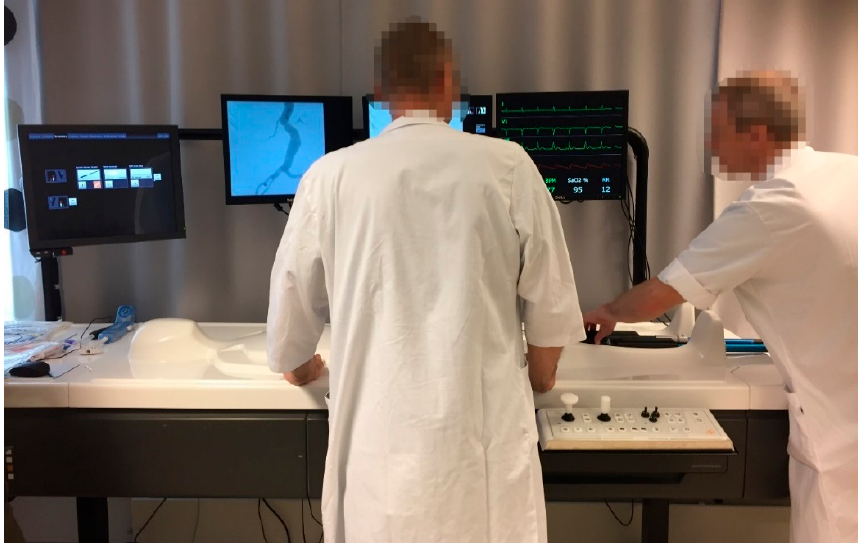
Figure 2. Testing the endovascular aneurysm repair (EVAR) simulator (courtesy: Våpenstad).